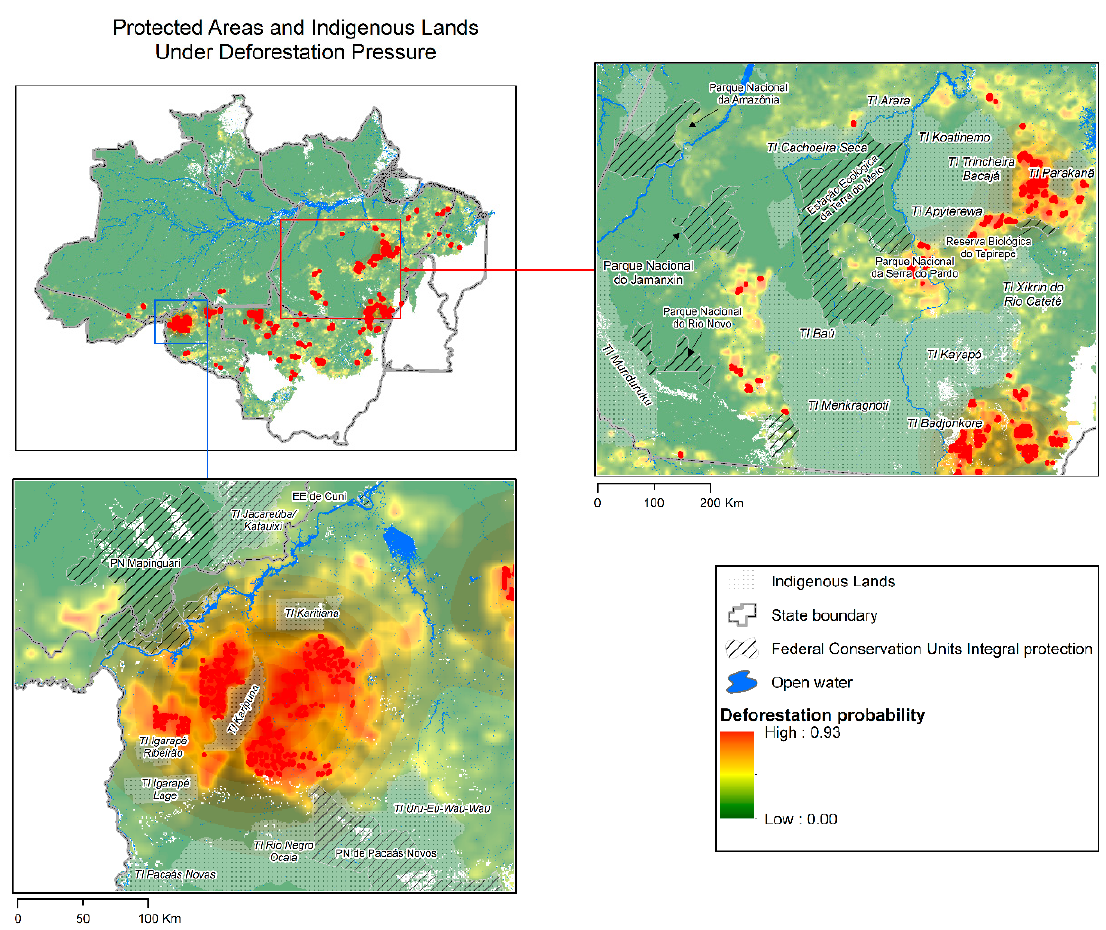
Figure 7. Indigenous lands and conservation units near hotspots of predicted deforestation. Note: Predicted deforestation raster cells were converted to points for better cartographic display.